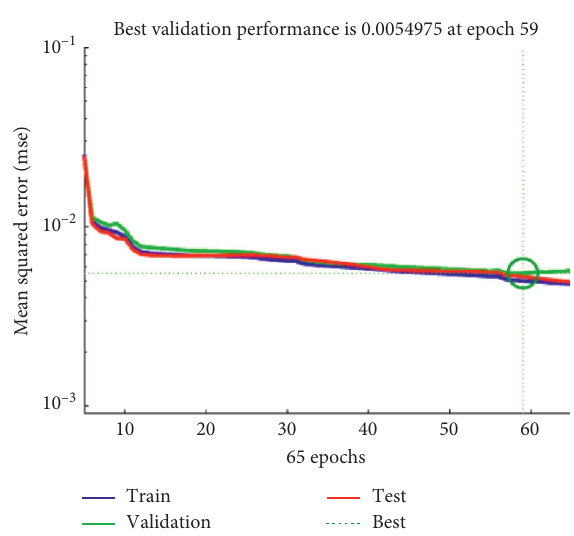
Figure 3: Training error of the BP network reverse model. Figure 4: Training error of the GA-BP network reverse